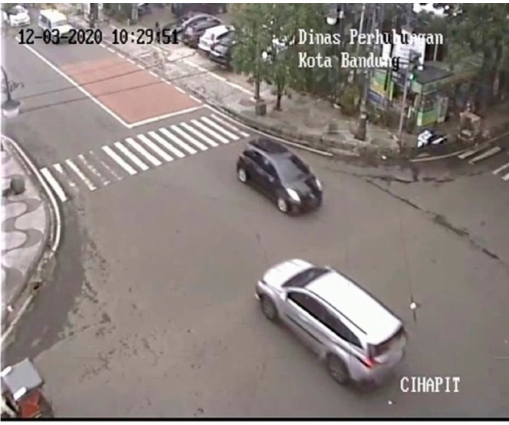
Figure 3. Sample Frame of CCTV Stream.